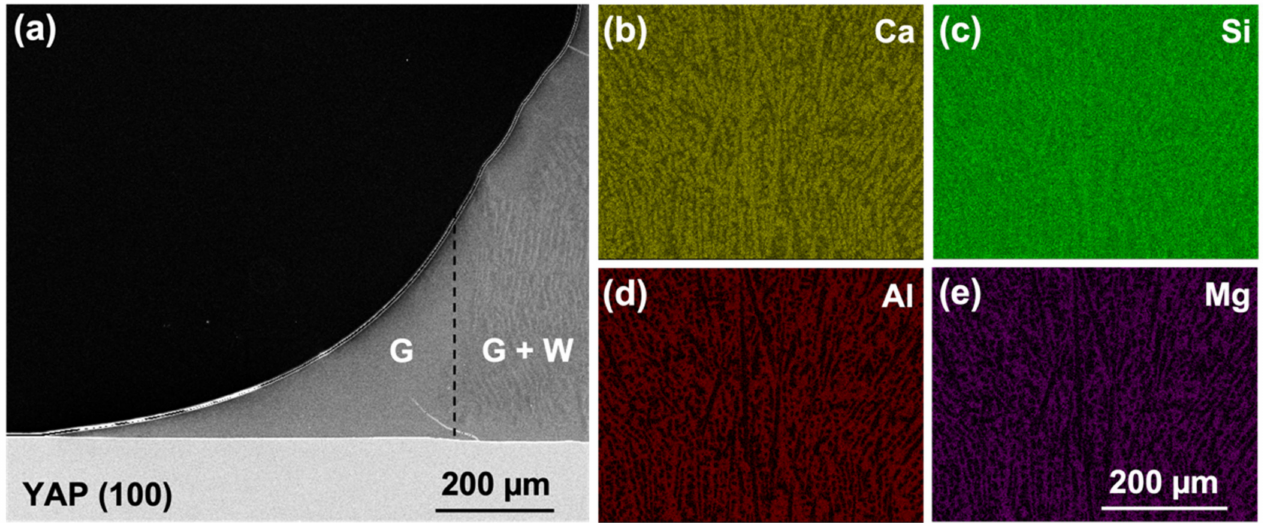
Figure 2. ( a ) Cross-sectional SE micrograph of the edge of the (100) YAP/CMAS reaction region after 10 min at 1350 ◦ C. Labels G and W indicate the CMAS-glass and wollastonite phase, respectively. Elemental EDS maps of ( b ) Ca, ( c ) Si, ( d ) Al, ( e ) Mg collected from within the CMAS drop in the same sample as ( a ).